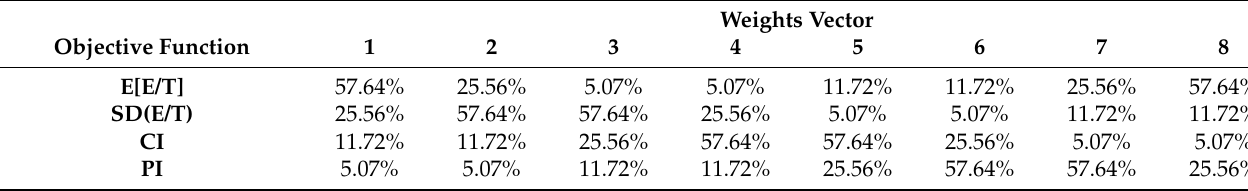
Table 5. Criteria weights for Pareto solutions.